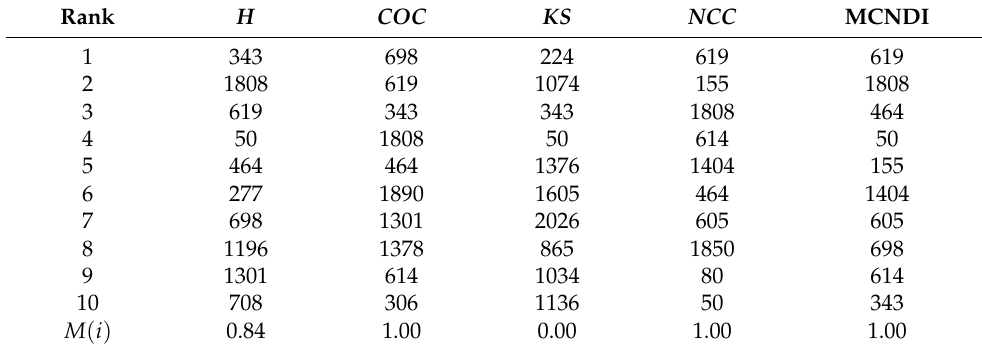
Table 2. Technology routes